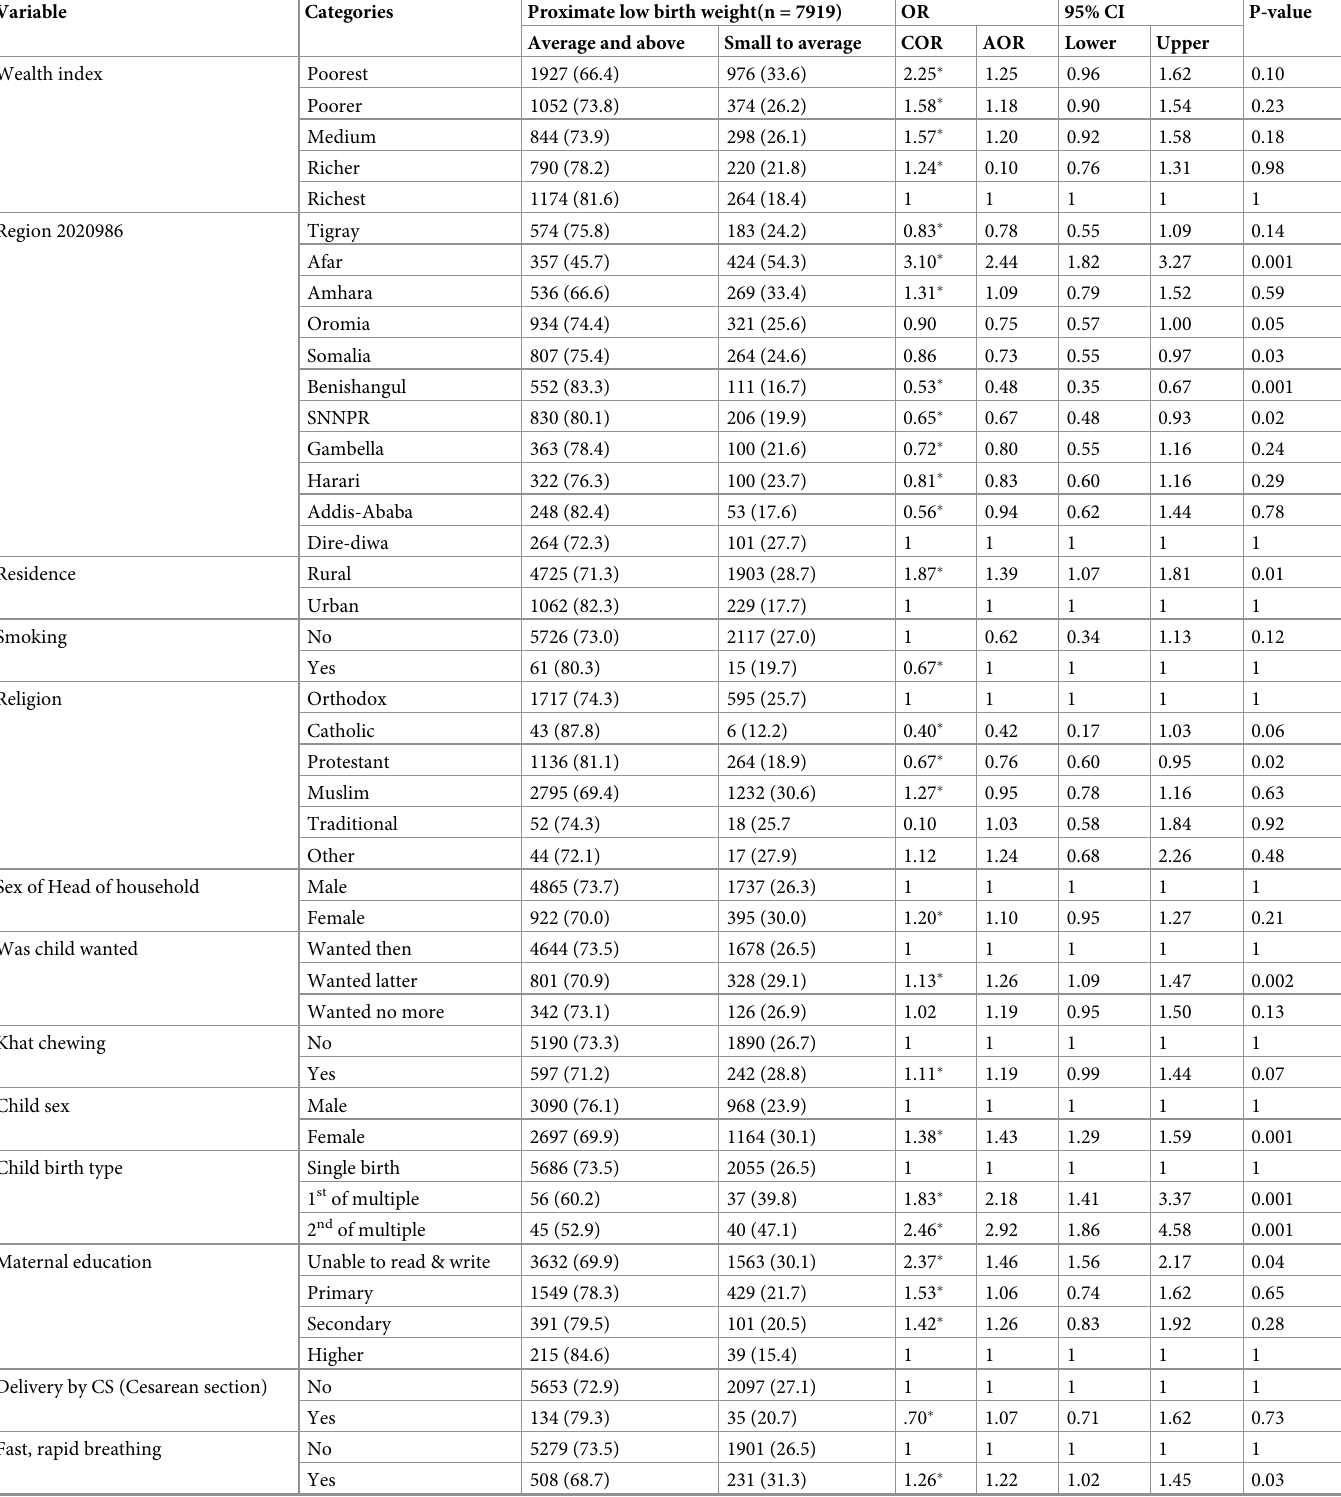
Table 2. The association of proximate low birth weight and potential determinants in Ethiopia.